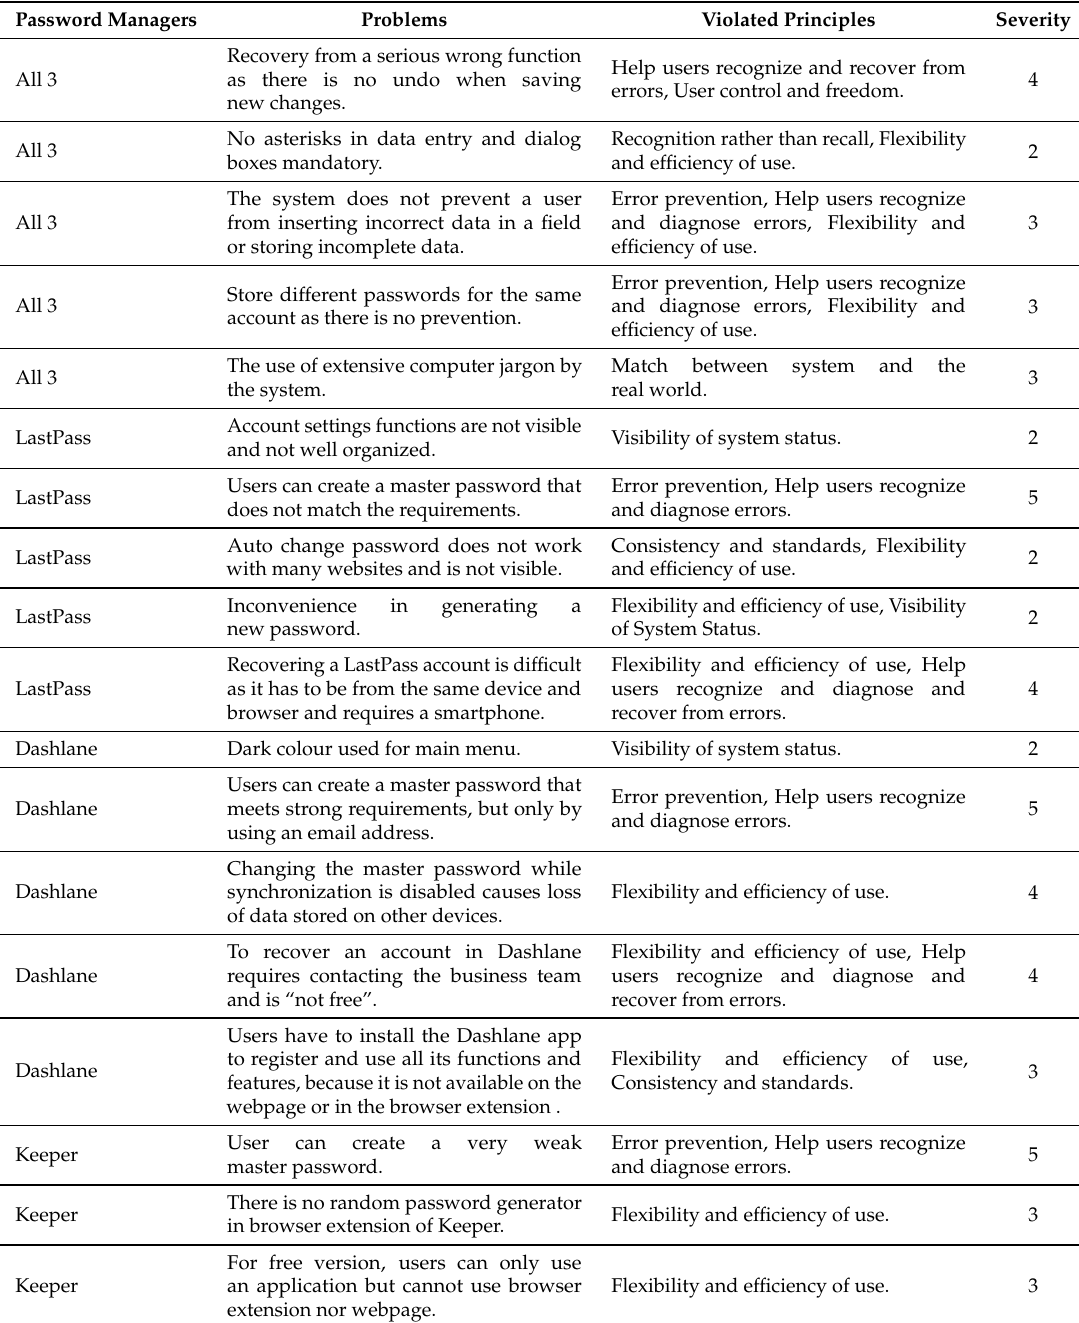
Table 7. Problems, violations of Nielsen’s principles and severity ratings for LastPass, Dashlane and Keeper. Explanation of problems and recommendations can be found in the Appendix A.2, along with all figures “from Figure A1 to Figure